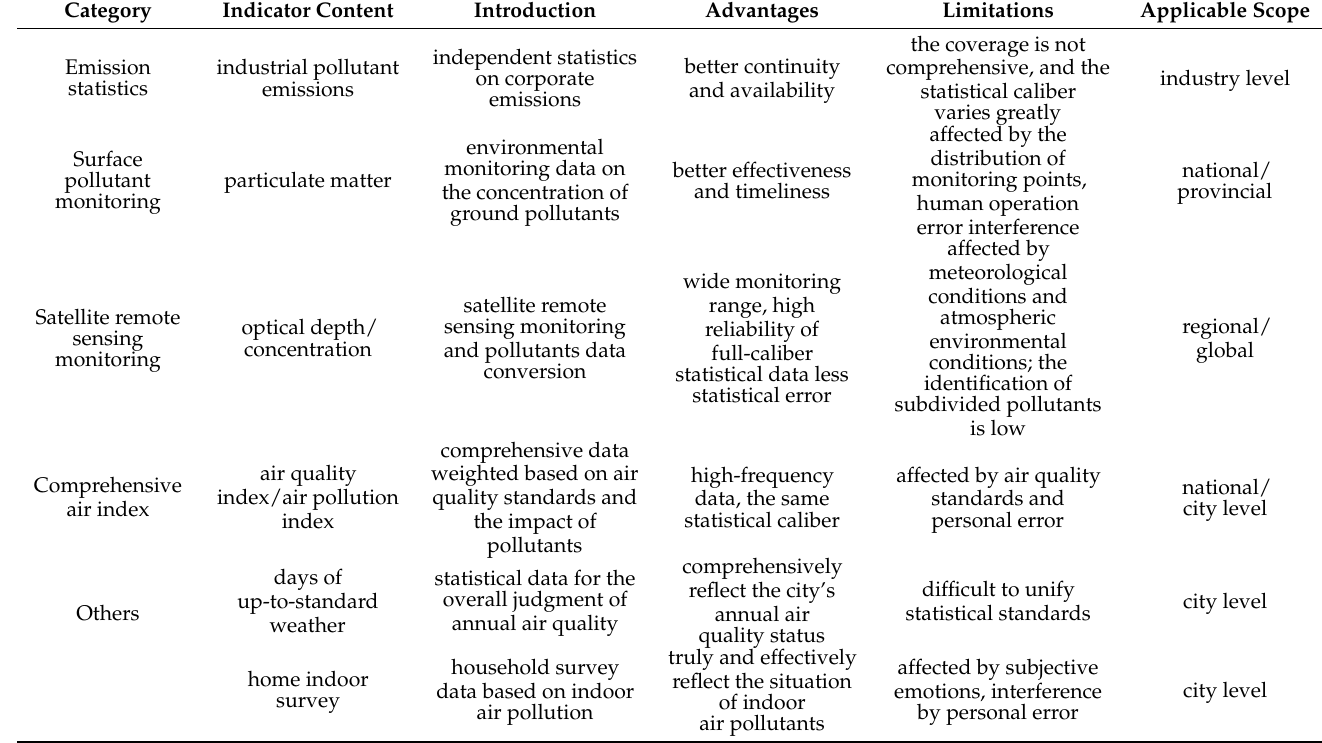
Table 1. Comparative analysis and evaluation of measurement indicator systems for haze